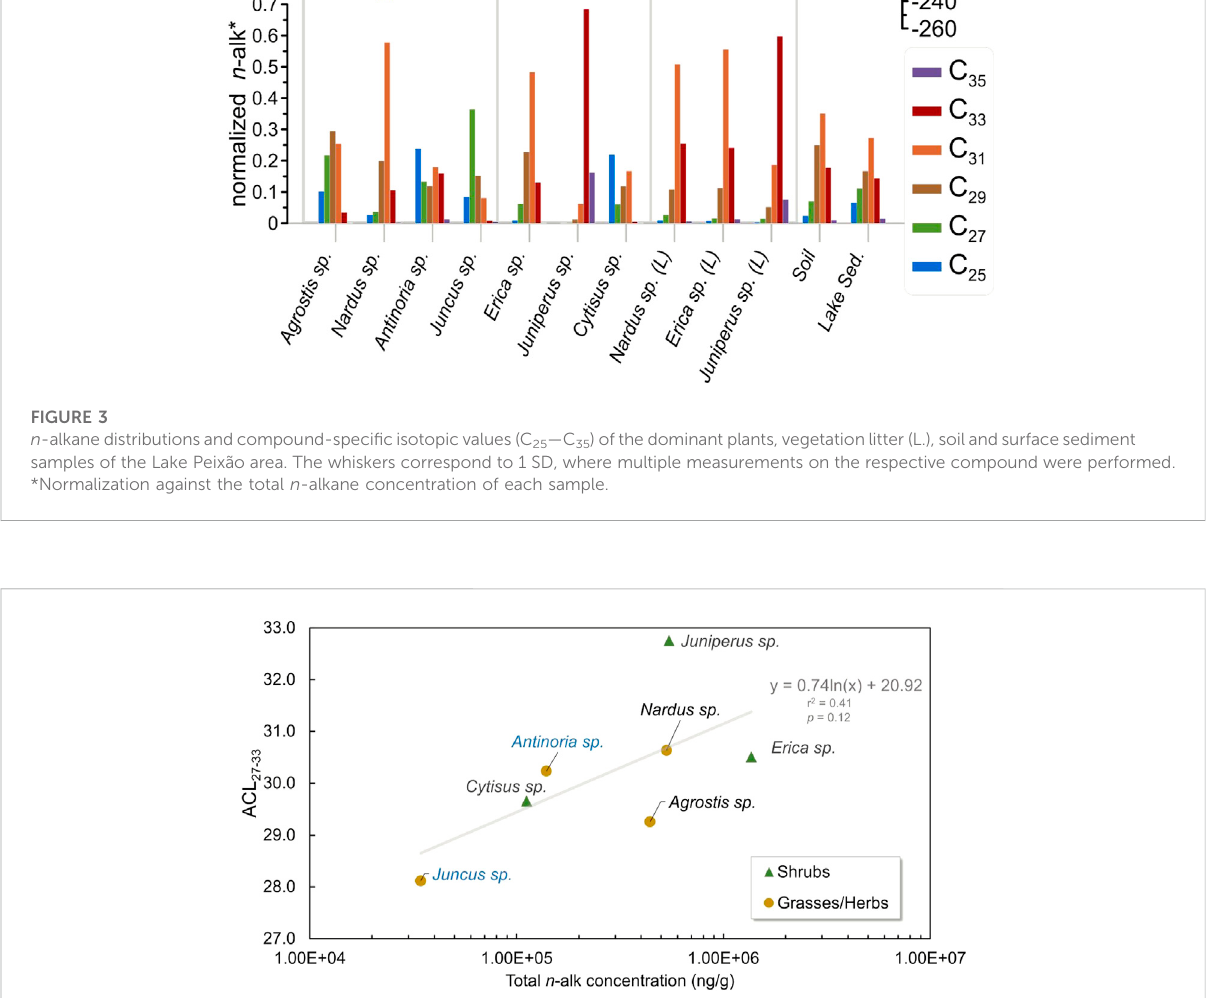
FIGURE 4 ACL 27-33 vs. total n -alkane concentrations (ng/g, in logarithmic scale) of thetwo dominant ecologicalforms of theLake Peixão catchment. The overalltrendisrepresentedbyalogarithmregressionlineingray.Greentrianglesrepresentshrubs;coloredcirclesrepresentgrasses/herbs,aquatic- related plants in blue, and nonaquatic plants in